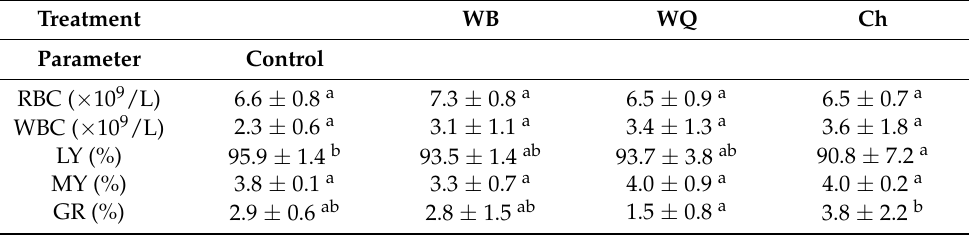
Table 3. Total red blood cells (RBC) and leukocyte (WBC) counts, and lymphoid (LY), myeloid (MY), and granulocytes (GR) percentages (%) in peripheral blood of iron-deficient mice. Wheat bread (WB), white quinoa bread (WQ) and chia bread (Ch). Results are expressed as mean ± standard deviation ( n = 5–6). Different superscript letters (a–c) indicate statistical differences ( p <